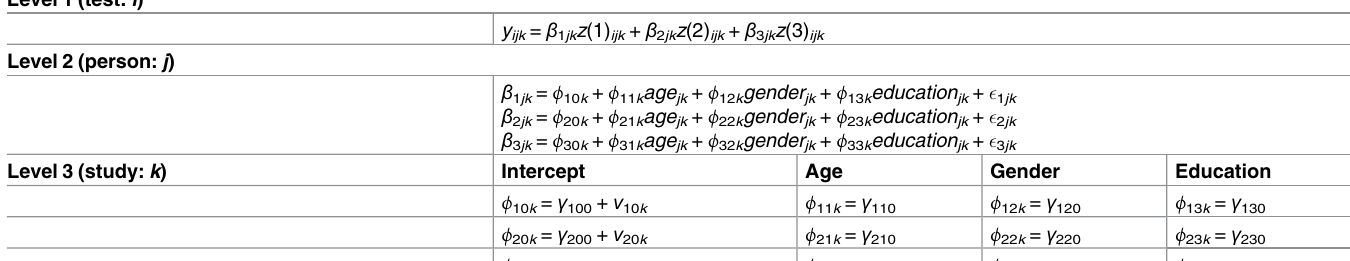
Table 3. Model specification for a multilevel model with three tests, and three background variables (age, gender and level of education), including specification of between and within study covariancestructures. Level 1 (test: i